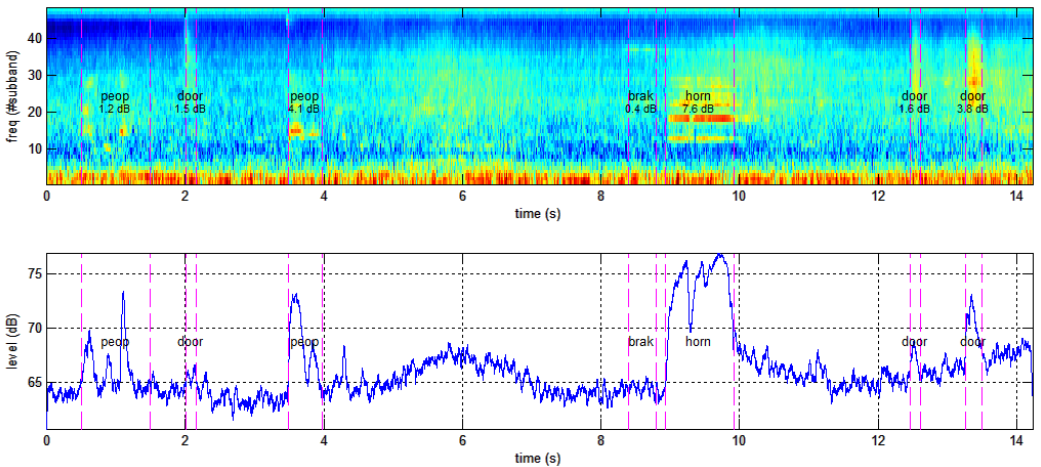
Figure A1. Example with up to seven ANEs obtained in a two-way street with two lanes each way in the urban scenario (city center of Milan). GTCC-based spectrogram (upper) and A-weighted equivalent noise levels (bottom) are